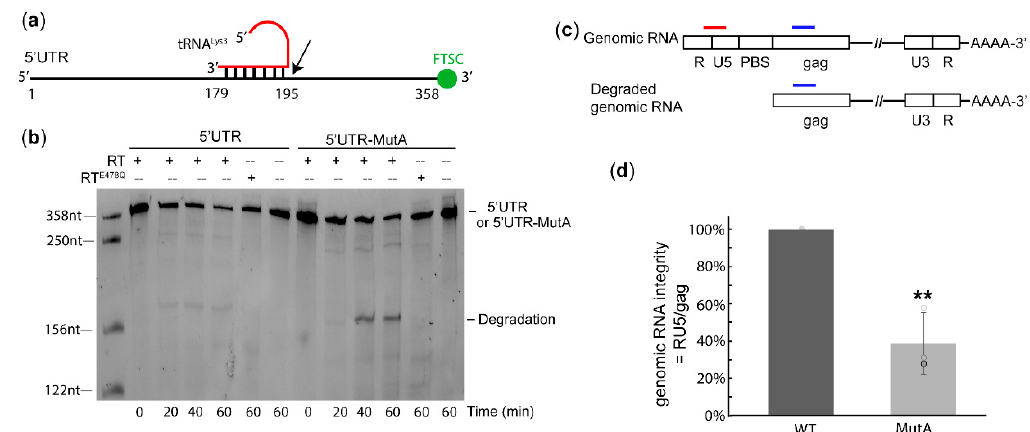
Figure 4. A-rich loop mutation in viral RNA (vRNA) resulted in accelerated RNA degradation in both in vitro and in cell-based assays. ( a ) Schematic diagram for the in vitro degradation assay. tRNA Lys3 was annealed to 3 ′ -fluorescein thiosemicarbazide (FTSC)-labeled 5 ′ UTR or 5 ′ UTR-MutA. Black arrow marks the approximate RNaseH degradation site. ( b ) In vitro degradation assay of the 5 ′ UTR: tRNA Lys3 and 5 ′ UTR-MutA: tRNA Lys3 complexes shows enhanced degradation of the mutant complex. ( c ) Schematic diagram of cell-based genomic integrity assay. Primers targeting the RNA upstream and downstream of PBS are sketched in red and blue, respectively. ( d ) Genomic RNA integrity assay shows decreased genomic RNA integrity upon mutation of the A-rich loop. Graph is representative of three experiments, average ± standard deviation; ** p < 0.01.